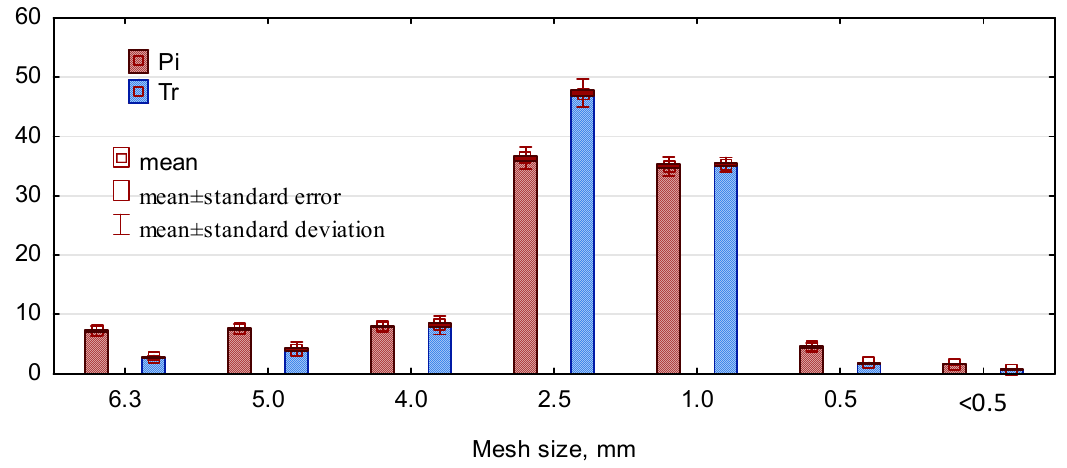
Figure 2. Sieve analysis of lignocellulose particles used in the study, (Pi—pine chips, Tr—triticale straw chips).